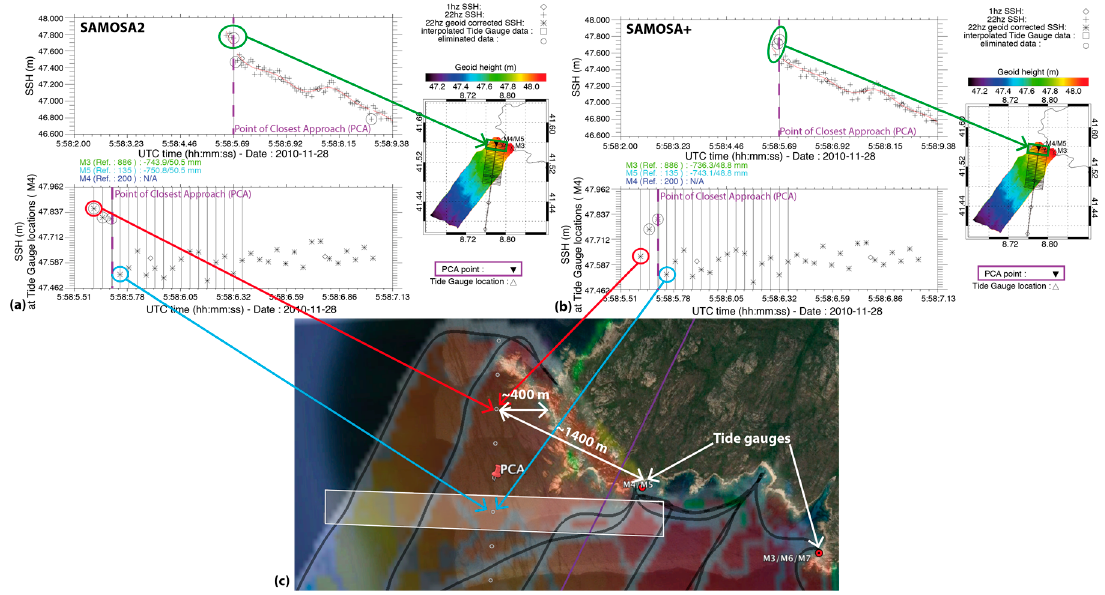
Figure 8. Example of retracking improvement for pass #2426 cycle 001. The upper panels of ( a ) and ( b ) show the altimeter SSH (crosses) without geoid correction, while the lower ones show the altimeter SSH after geoid correction (stars with error bars). An automatic outlier detection is performed and the rejected data are circled. ( a ) Corresponds to the G-POD standard retracking (SAMOSA2) while ( b ) corresponds to the improved retracking (SAMOSA+ is the SAMOSA2 model tailored for inland water, sea ice and coastal zone domains). ( c ) Shows a zoom of the data locations (circles) very close to the coast; the white rectangle represents the SAR footprint for one data; the black lines correspond to the Catamaran-GPS tracks [4] that were used to map the Senetosa geoid (colored map in background).